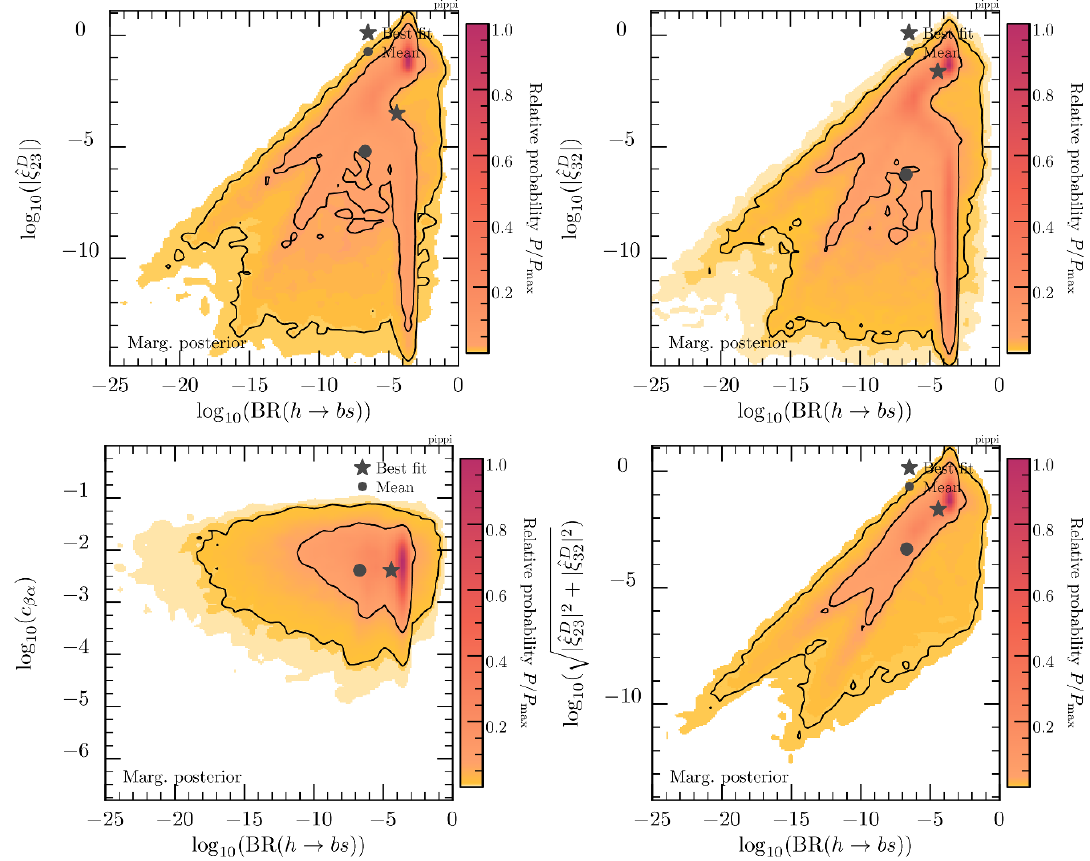
Figure 10 . O(cid:11)-diagonal down-quark Yukawa couplings ^ (cid:24) D versus log [right] : log ( j ^ (cid:24) D j ) [log ( j ^ (cid:24) D j )] Bottom left : the logarithm of the physical angle c (cid:12) (cid:0) (cid:11) versus 10 10 23 32 log [BR( h ! bs )]. Bottom right : logarithm of the modulus of the o(cid:11)-diagonal contributions 10 to ^ (cid:24) D versus log [BR( h ! bs 10